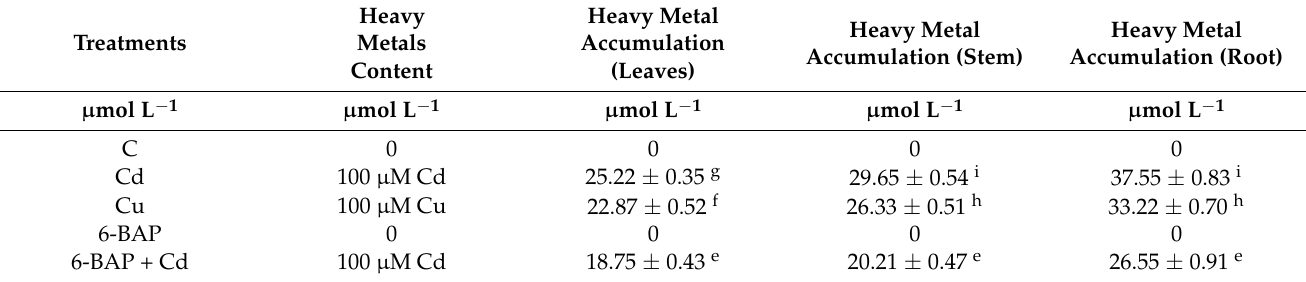
Table 6. The impact of 6-benzylaminopurine and abscisic acid, alone and in combination, on accu- mulation of cadmium and copper in the plant organs (leaves, stem and root) exposed to 100 µ M Cd and 100 µ M Cu. In this table, a, b, c, etc. letters revealed significant differences between control, 6-BAP, ABA, and the co-application of 6-BAP + ABA in both combined and single forms with 100 µ M cadmium and 100 µ M copper based on Tukey’s test ( p <